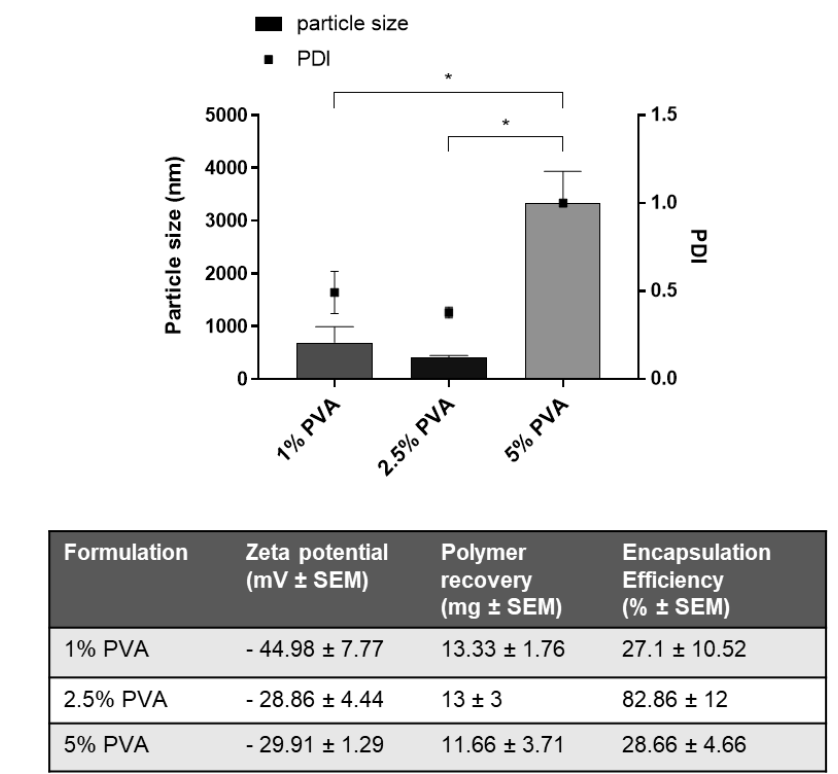
Figure 2. Physiochemical characteristics of vancomcyin-loaded PLGA RG 503H nanoparticles. ( A ) The effect of drug:polymer